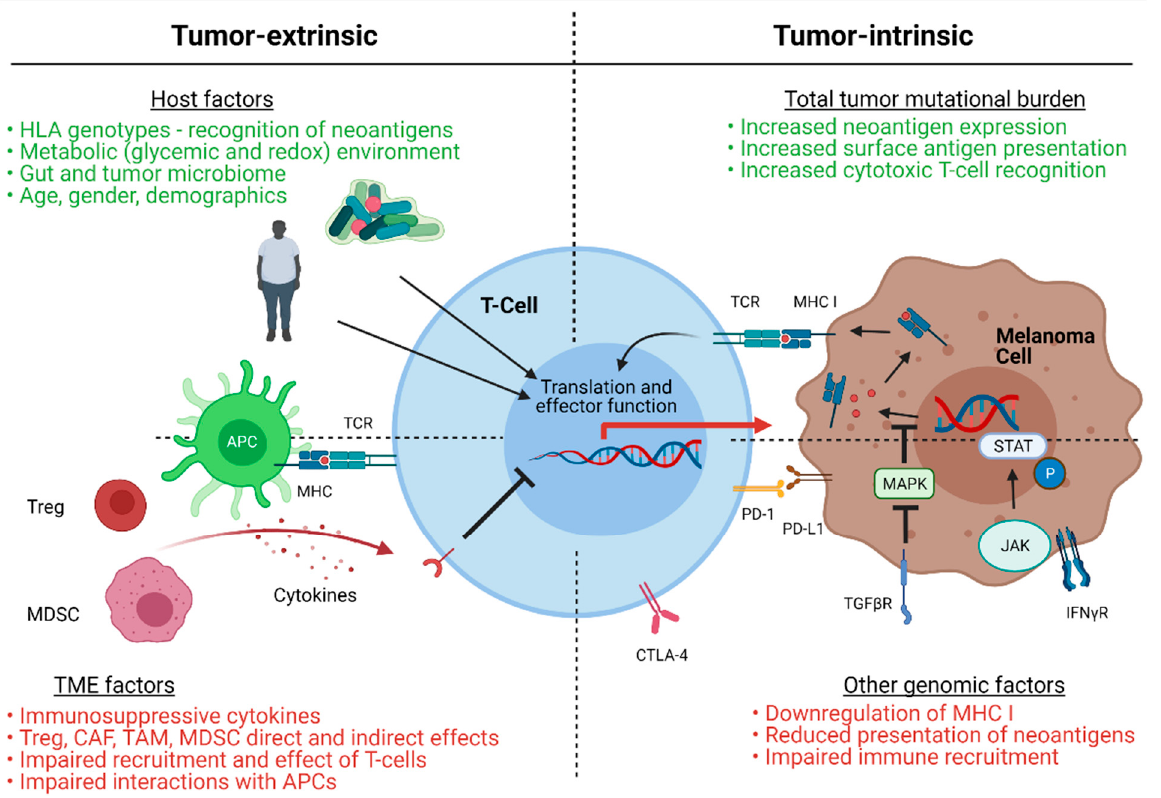
Figure 1. Proposed mechanisms of resistance to immune checkpoint inhibition in melanoma. In green are factors associated with potential immune checkpoint inhibitor responsiveness, while red highlights factors associated with potential resistance to therapy. Tumor extrinsic mechanisms include host factors and tumor microenvironment (TME) factors. Host factors include: immune recognition via specific human leukocyte antigen (HLA) genotypes, metabolic factors, such as obesity and diabetes; the gut/tumor microbiome; demographics, such as age or gender. TME factors include: an immunosuppressive cytokine milieu; the presence of regulatory T-cells (Treg); cancer associated fibroblasts (CAF); tumor associated macrophages (TAM)); myeloid derived suppressor cells (MDSC) and other cell types. Each elicits specific effects on T-cell recruitment and activity, and may impair interactions between antigen presenting cells (APCs) and T-cells. Tumor-intrinsic mechanisms include overall tumor mutational burden and other tumor genomic factors. High tumor mutational burden increases neoantigen expression and surface antigen presentation for recognition by activated cytotoxic T-lymphocytes, augmented with the use of immune checkpoint inhibition. Tumor cell mutation of specific oncogenic drivers or signaling pathways results in altered responses to interferon gamma and reduced presentation of neoantigens on major histocompatibility complex (MHC) I, ultimately altering immune effector recruitment and activation. TCR (T-cell receptor); PD-1 (programmed cell death protein-1); PD-L1 (programmed death-ligand 1); CTLA-4 (cytotoxic T-lymphocyte antigen 4); MAPK (mitogen activated protein kinase); STAT (signal transducer and activator of transcription); JAK (Janus kinase); TGF β R (transforming growth factor beta receptor); INF γ R (interferon gamma receptor); P